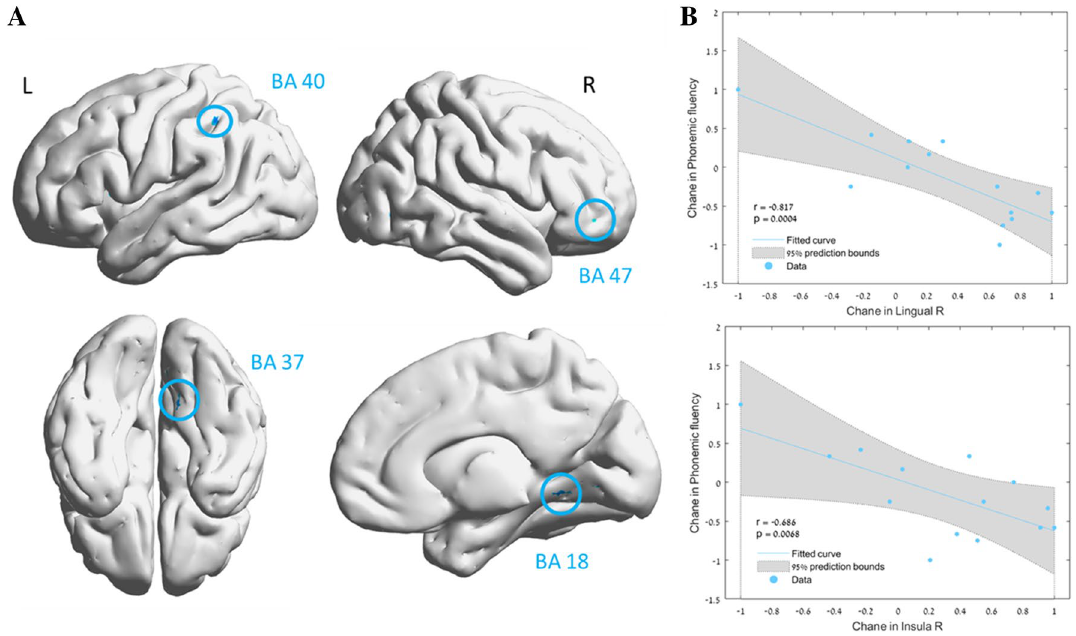
Figure 5. Brain regions with significant post HBOT changes in mean diffusivity (MD). Group-by-time interaction ANOVA model in: ( A ) DTI—mean diffusivity (MD) in gray matter, p < 0.005, uncorrected ( B ). Significant correlation between change in phonemic fluency and the right lingual MD (BA 18), and right insula MD (BA 13). r is Pearson’s correlation coefficient. The 95% prediction interval is presented in the shaded area. R right, L left, BA Brodmann area. Brain images were created using BrainNet Viewer Software (http:// www. nitrc. org/ proje cts/